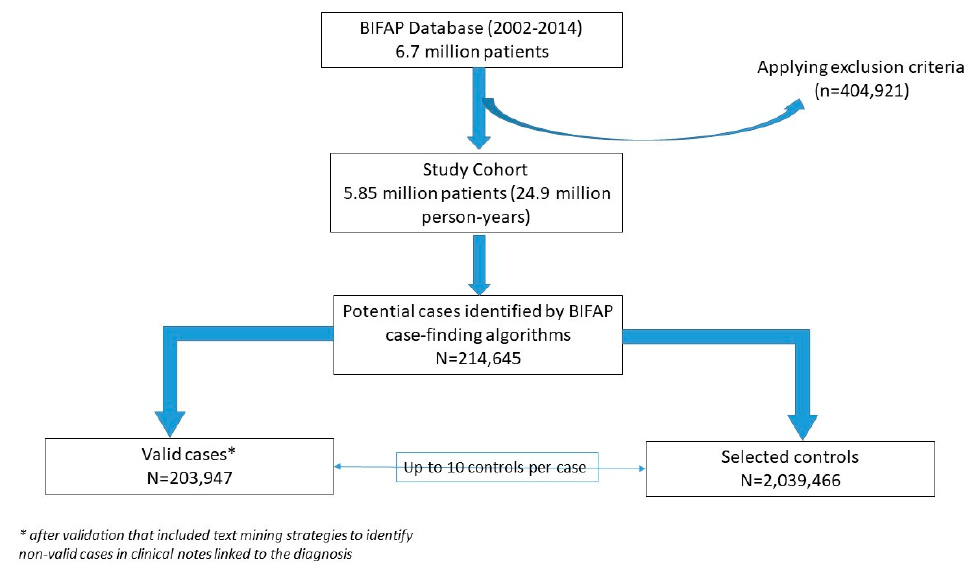
Figure 1. Flow chart showing the identification processes of cases and controls in the Base de datos